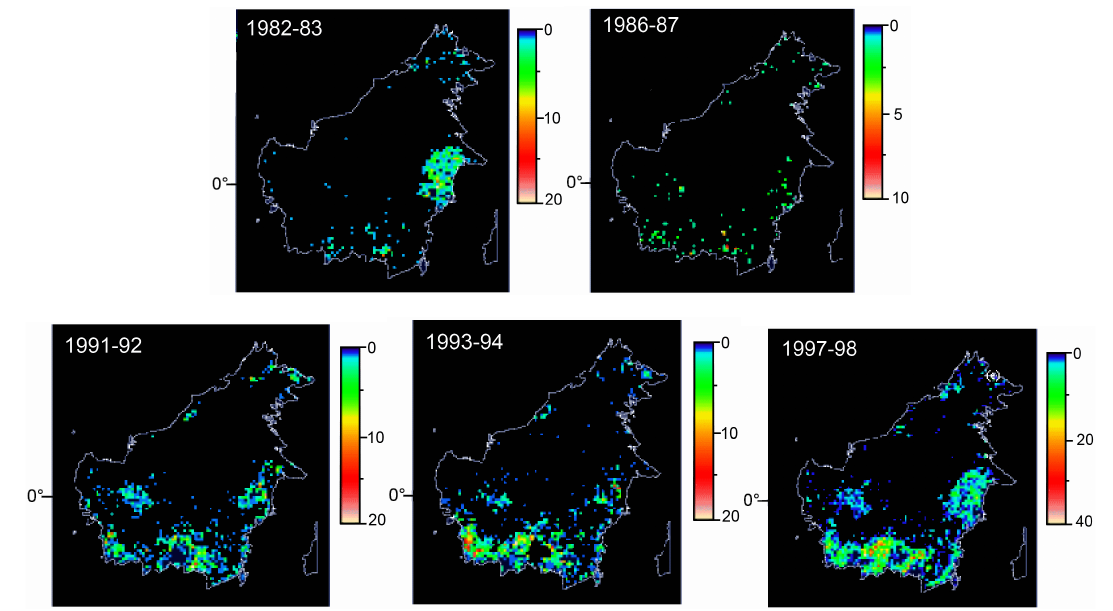
Fig. 8. Maps depicting the spatial pattern and density of active fire pixel counts detected using AVHRR GAC data during the five El Ni˜no episodes occurring between 1980 and 2000. Grid cells are 12km × 12 km, and colours indicate the number of active fire pixels detected in each grid cell during the full 24 months covering each El Ni˜no event (i.e. Jan ENSO Year 1 to Dec ENSO Year 2), a period including all three fire-subseasons depicted in Fig. 9. The 1982–1983 El Ni˜no, and to a lesser extent the 1997–1998 El Ni˜no, are those having the highest proportion of fire activity in the northern half of the island (in East Kalimantan). Note the different colour-scales used for the 1986–1987 and 1997–1998 El Ni˜no events, required to accommodate the relatively low and high active fire count totals seen respectively in these two El